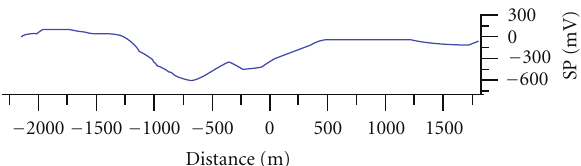
Figure 9: A self-potential profile along Waita volcano, Japan (Mauri et al.